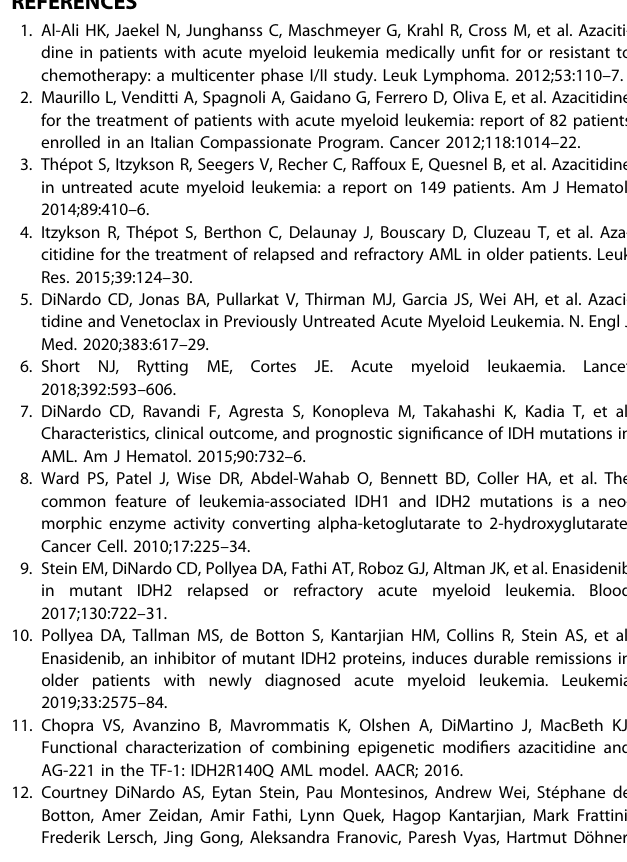
TEAE- Treatment emergent adverse event, IDH-DS- IDH inhibitor induced differentiation syndrome, AST- Aspartate aminotransferase, ALT- Alanine aminotransferase, GI- Gastrointestinal All results expressed as No. (%) or median [Minimum - maximum], unless speci fi